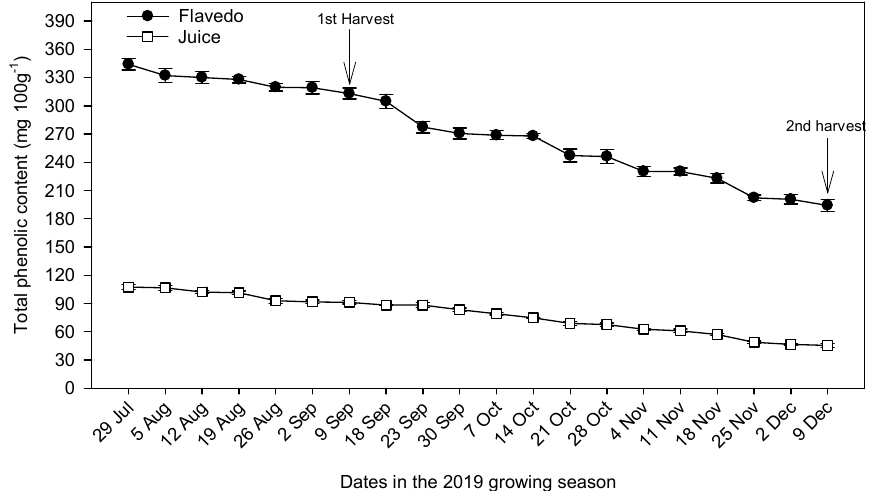
Figure 7. Evolution of the total phenolic content in flavedo and juice samples in lemon fruits during development and on-tree ripening in the 2019 growing season.